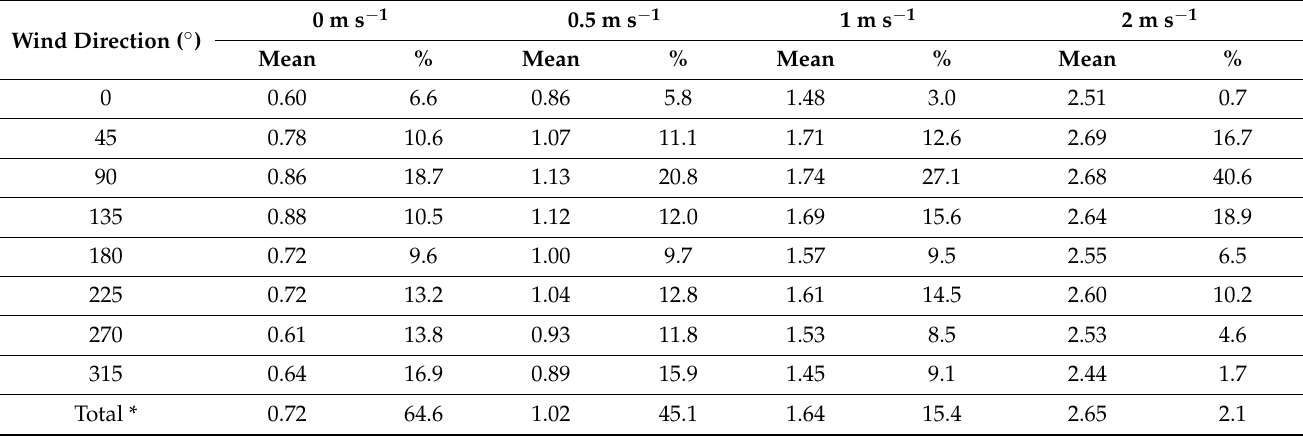
* Percentages in the total column indicate the proportion of frequency over the wind speed threshold for all